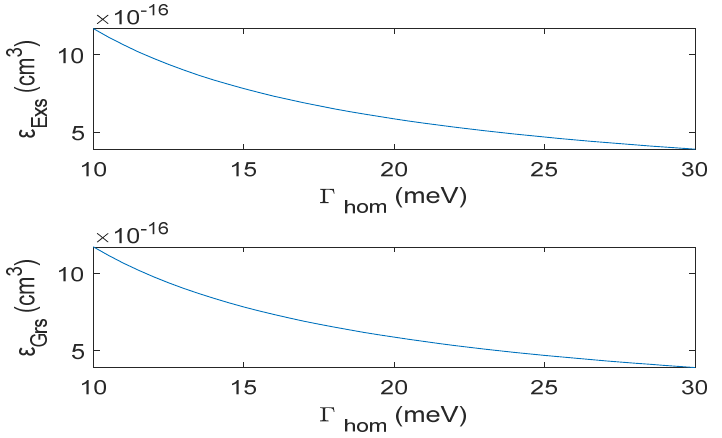
Γ hom for I rf = 40